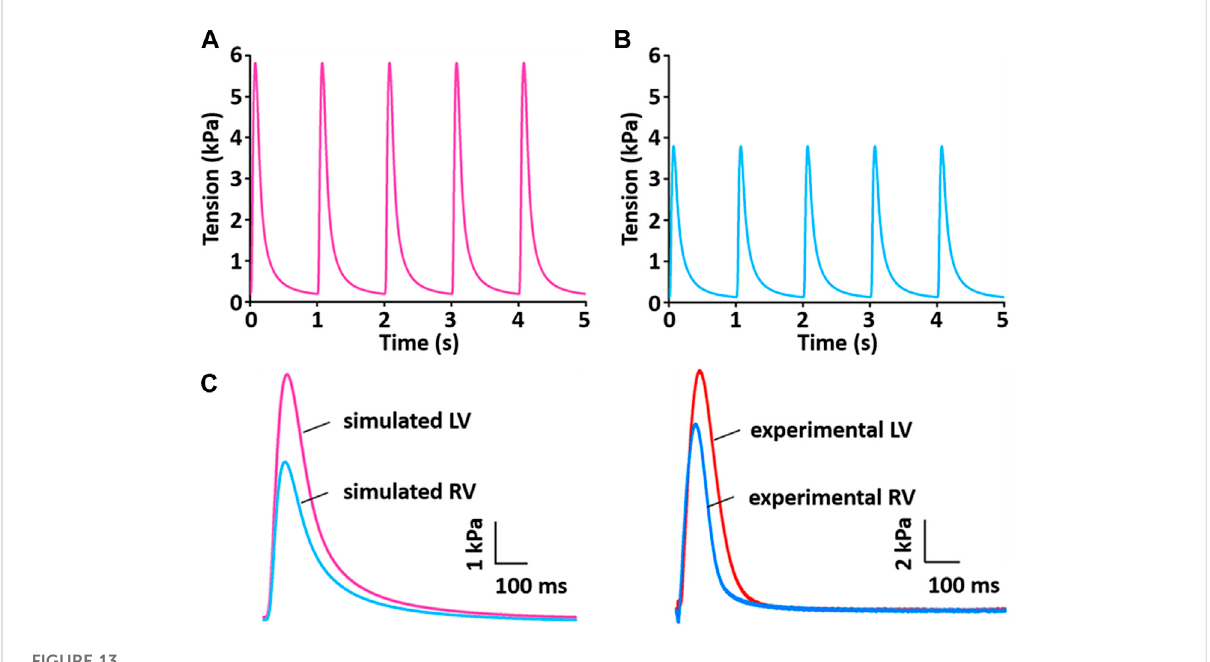
FIGURE 13 Model-generated tension production at 1 Hz and 37 ° C (Kim, 2018). (A) The tension traces for the LV model. (B) The tension traces for the RV model. (C) Comparison of simulated tension between LV and RV and validation of simulated tensions with experimentally recorded LV and RV